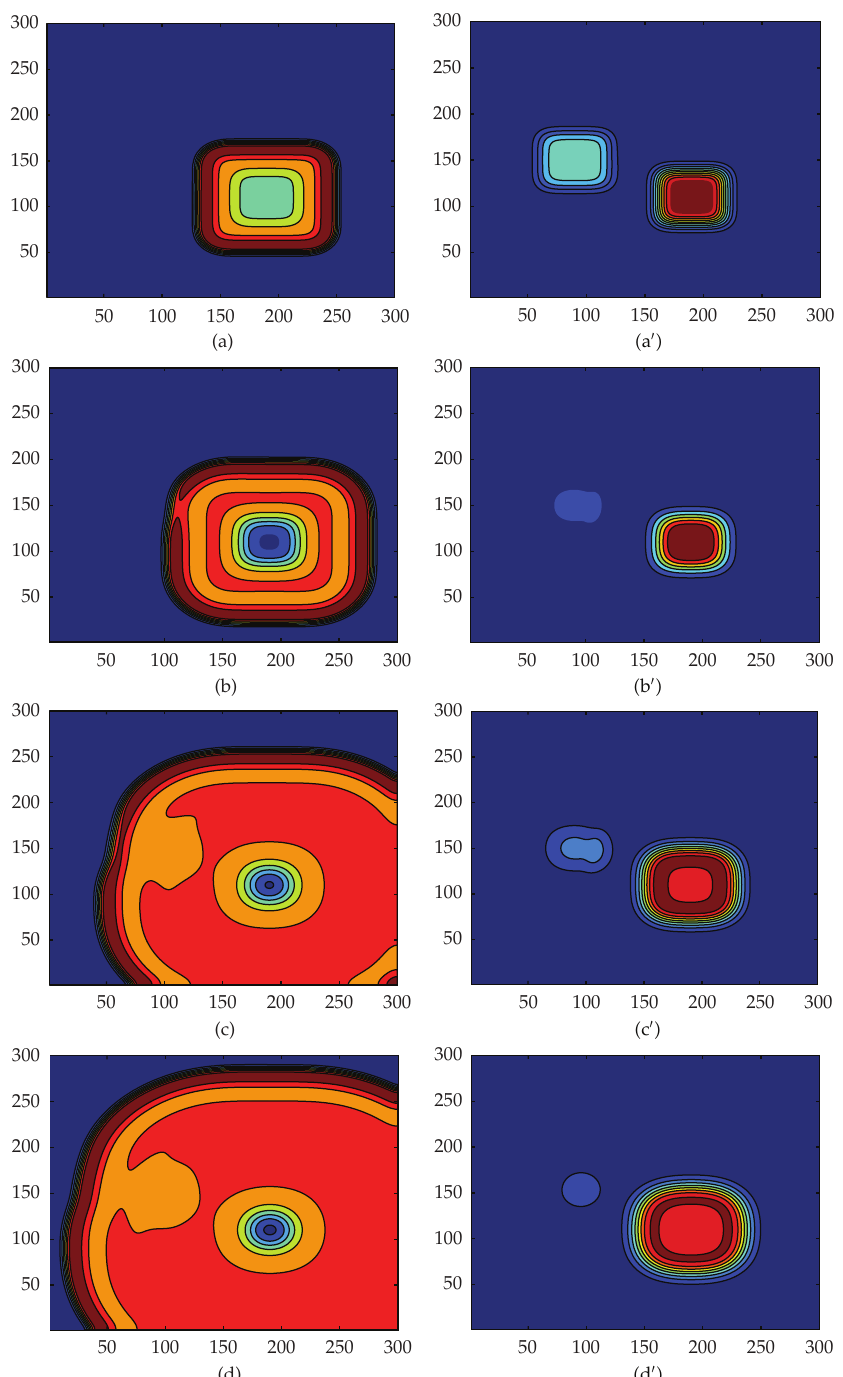
Figure 2: Typical spatial pattern of the density of IGprey (left column) and IGpredator (right column) in two-dimensional space for the system (2a)–(2c). Parameter values: 𝜅 1 = 0.7, 𝜅 2 = 0.2, 𝜅 3 = 0.23, 𝛼 = 2, ℎ = 0.5, 𝑒 1 = 0.1 , 𝑒 2 = 0.21, 𝜀 1 = 1 , and 𝜀 2 = 1.5 . From the top row to bottom, panel represents spatial patterns at time 100, 300, 600, and 1,000, respectively.